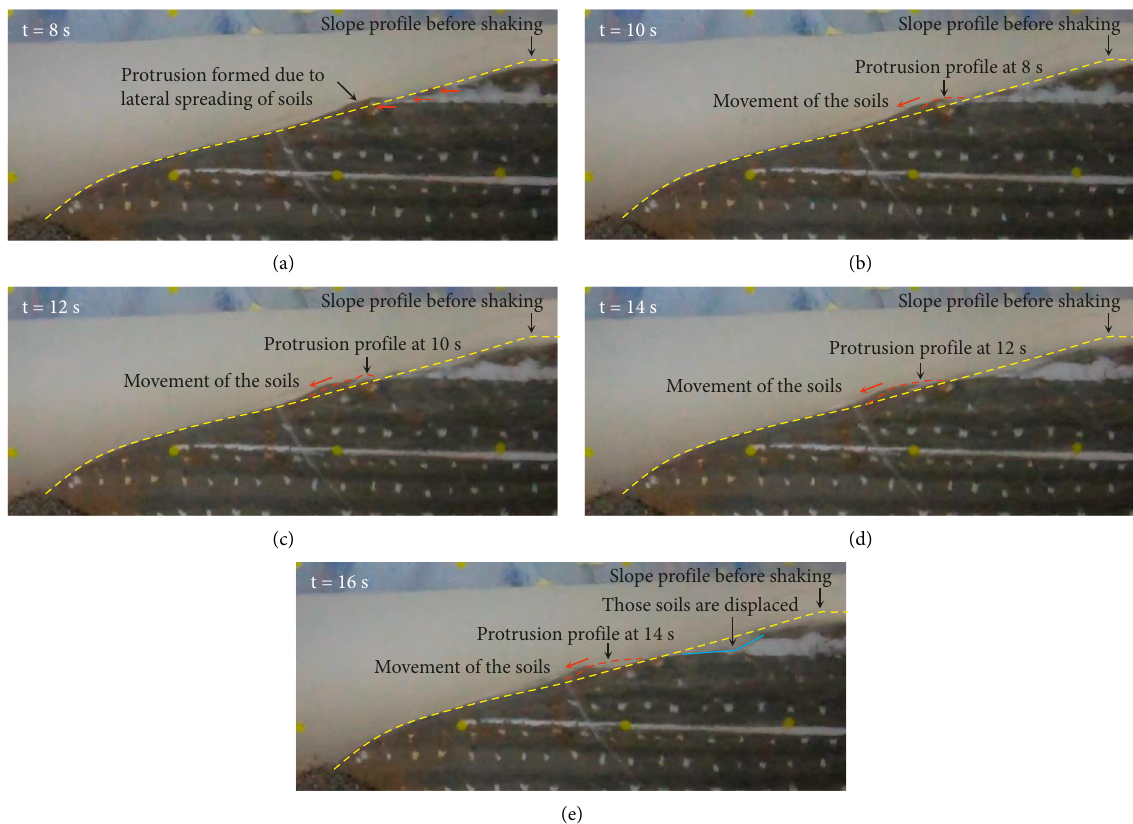
Figure 12: Snapshots of the tailings slope during stage 2: (a) t � 8 s. (b) t � 10s. (c) t � 12s. (d) t � 14s. (e) t �